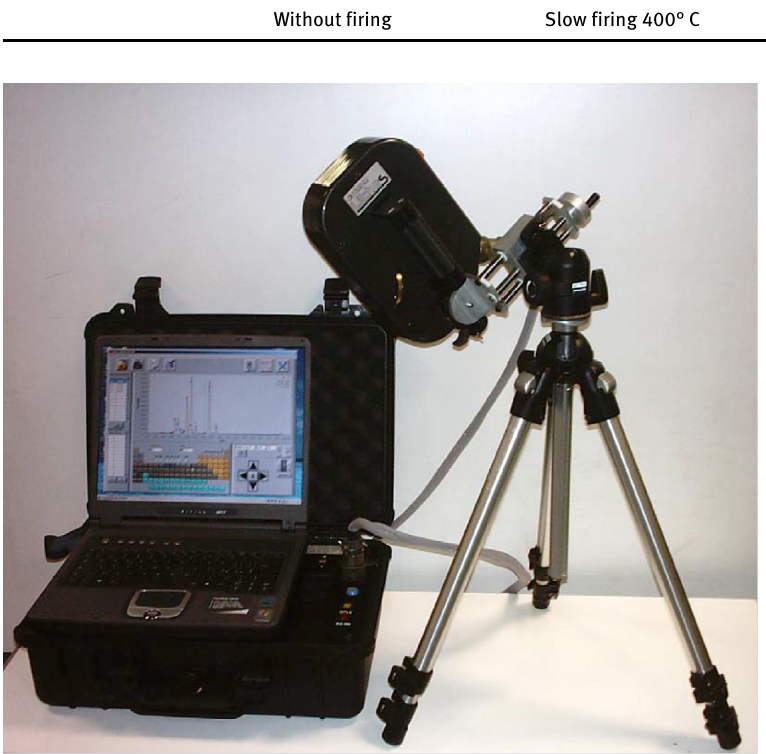
Figure 2. Picture of the X-ray spectrometer ASSIGN Lithos